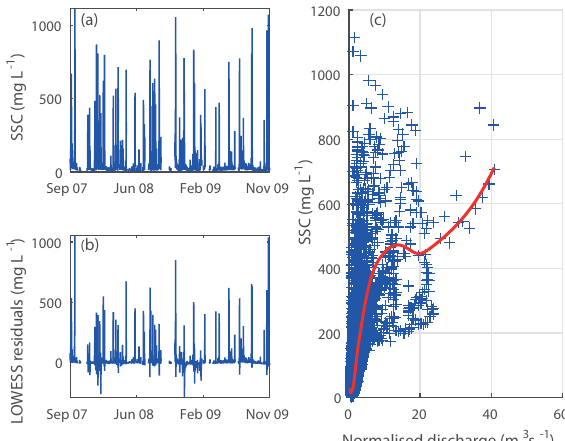
Figure 6. (a) Suspended sediment concentrations and (b) residu- als over the entire monitoring period as a result of (c) the LOWESS model developed between normalized discharge and suspended sed- iment